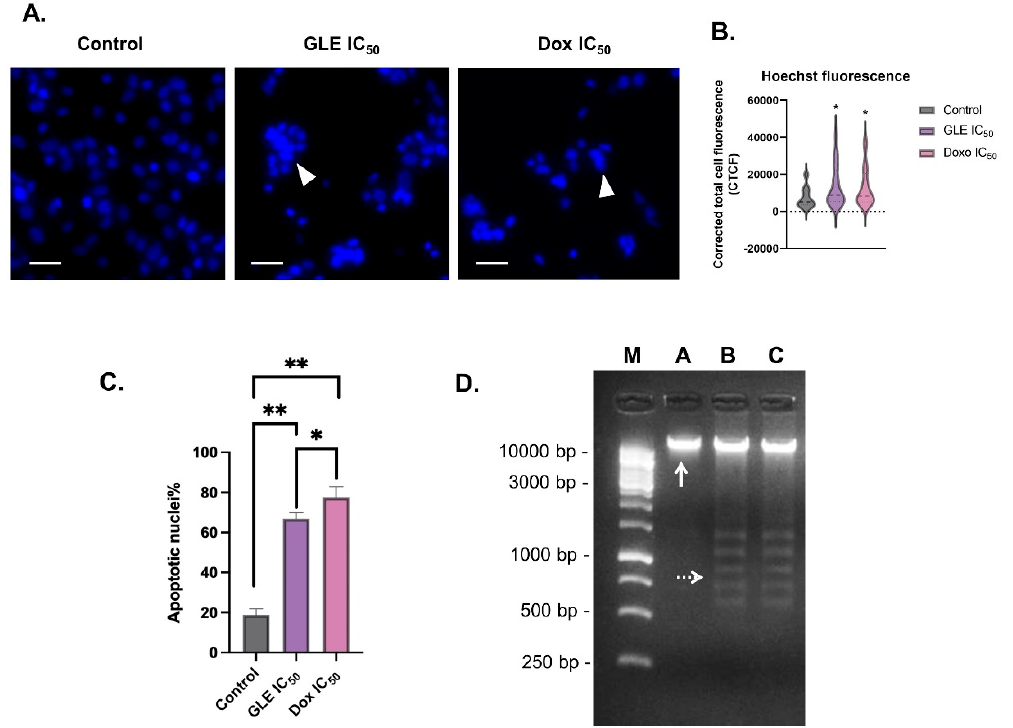
Figure 4. Apoptosis-inducing effects of GLE in B16-F10 melanoma cells: ( A ) Staining with Hoechst33342 reveals chromatin condensation in apoptotic cells; arrowheads = apoptotic nuclei. ( B ) Corrected total cell fluorescence (CTCF) values of B16-F10 cells treated with GLE and doxorubicin at IC 50 concentrations. ( C ) Calculation of apoptotic nuclei percentage in B16-F10 cells treated with IC 50 concentrations of GLE and doxorubicin. ( D ) Fragmentation of B16-F10 genomic DNA treated with GLE; a 1 kb DNA ladder (250–10,000 bp) was used as a standard; M: DNA 1 kb marker; A: control; B: GLE IC 50 concentration; C: doxorubicin IC 50 concentration. * Indicates significant difference compared to control ( p < 0.05); ** indicates highly significant difference compared to control ( p < 0.01). Arrowheads = apoptotic nuclei. White arrows indicate genomic DNA. White dotted arrows show fragmented DNA. Scale = 25 µm.